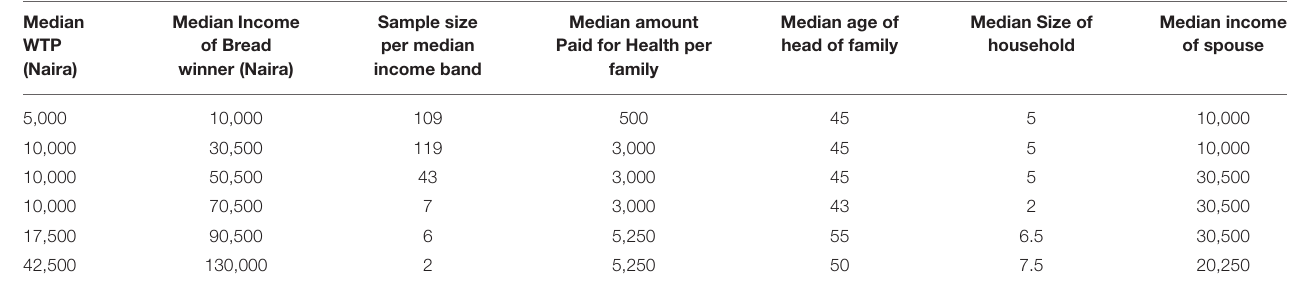
TABLE 5 | Median values of WTP across covariates in multiple